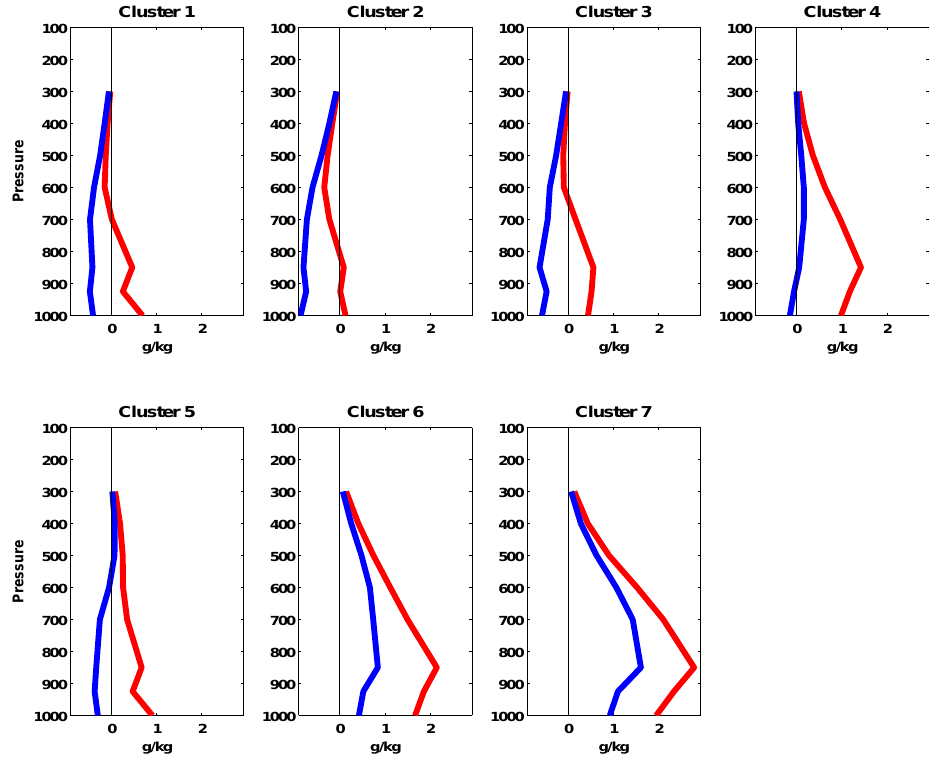
Fig. 16. As in Fig. 14, except for specific humidity anomalies. Table 8. Total SWCRF and sum of LWCRF component changes for each cluster and the average from the midlatitude based on relative frequency of occurrence. (Subsets different at the 95% confidence level are in